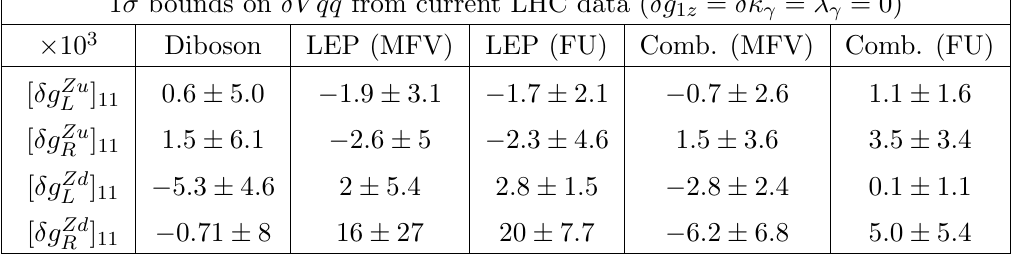
Table 4 . Constraints ( (cid:2) 10 3 ) on the (cid:14)V (cid:22) qq vertex corrections from a (cid:12)ve parameter global (cid:12)t combining LHC diboson data and LEP-1 measurements, setting (cid:14)g 1 z = (cid:14)(cid:20) (cid:13) = (cid:21) (cid:13) = 0. The (cid:12)rst column gives the bounds using the LHC diboson data alone. The second and third columns report the LEP-1 bounds derived in ref. [27] under the MFV and FU assumptions respectively. Finally, the last two columns show the combination of the current LHC and LEP-1 data for the two (cid:13)avour assumptions.